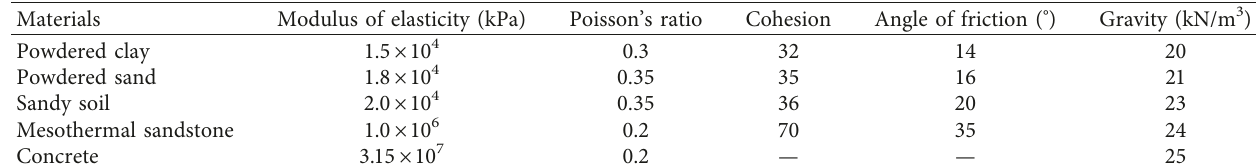
Table 2: Model material property parameters.